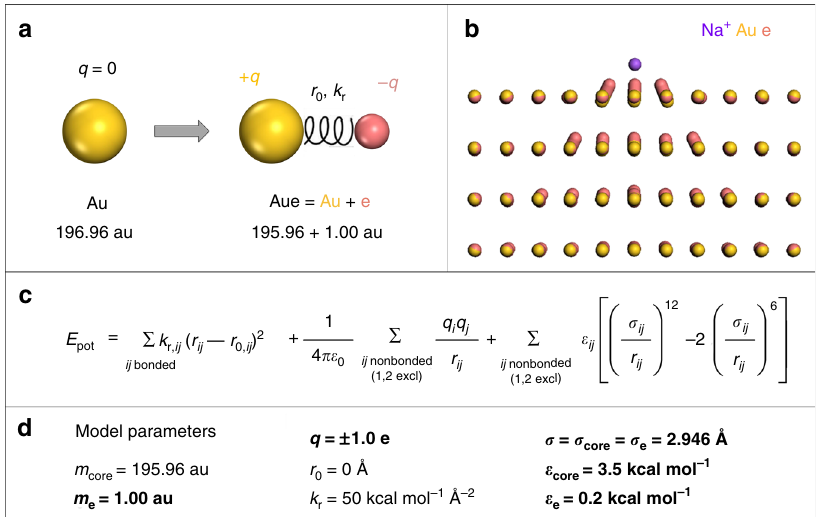
Fig. 1 Polarizable Lennard – Jones model for gold. a Extension of the simple Lennard – Jones model with dummy electrons to add features of the free electron gas. The virtual electrons rest at the atom core and carry a mass of 1 au. b Visualization of the dummy electrons on the Au (111) surface in the presence of an adsorbed sodium ion in vacuum. The induced charges spread across several atomic layers laterally and beneath the top atomic layer. c The energy expression contains terms for harmonic bond stretching, Coulomb energy, and van-der-Waals energy (Lennard – Jones potential). d The model uses fi ve independent parameters (highlighted in bold) including the mass of the dummy electron m e , a combination of the charge q and the bond stretching constant k r , whereby a certain ratio α = q 2 /(2 k r ) determines the magnitude of the image potential, as well as the Lennard – Jones parameters σ , ε core , and ε e . The total mass of the gold atom ( m core + m e ) and the rest position of the dummy electron r 0 = 0 Å are